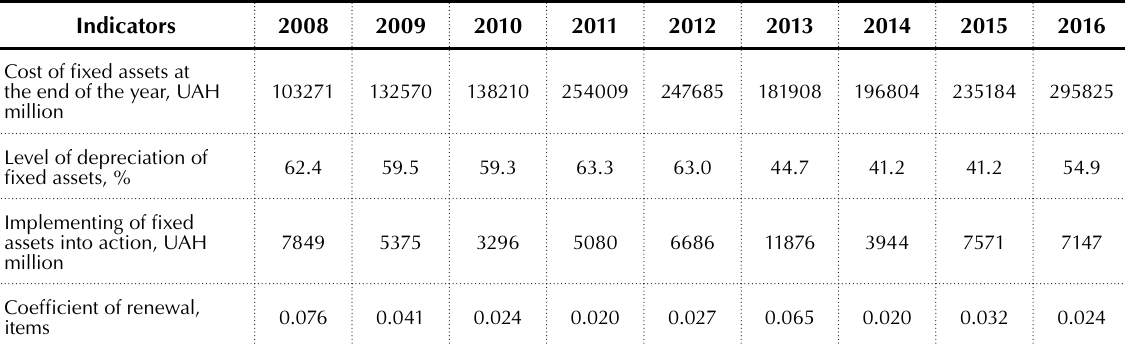
Table 3. Fixed assets of metallurgical industry in